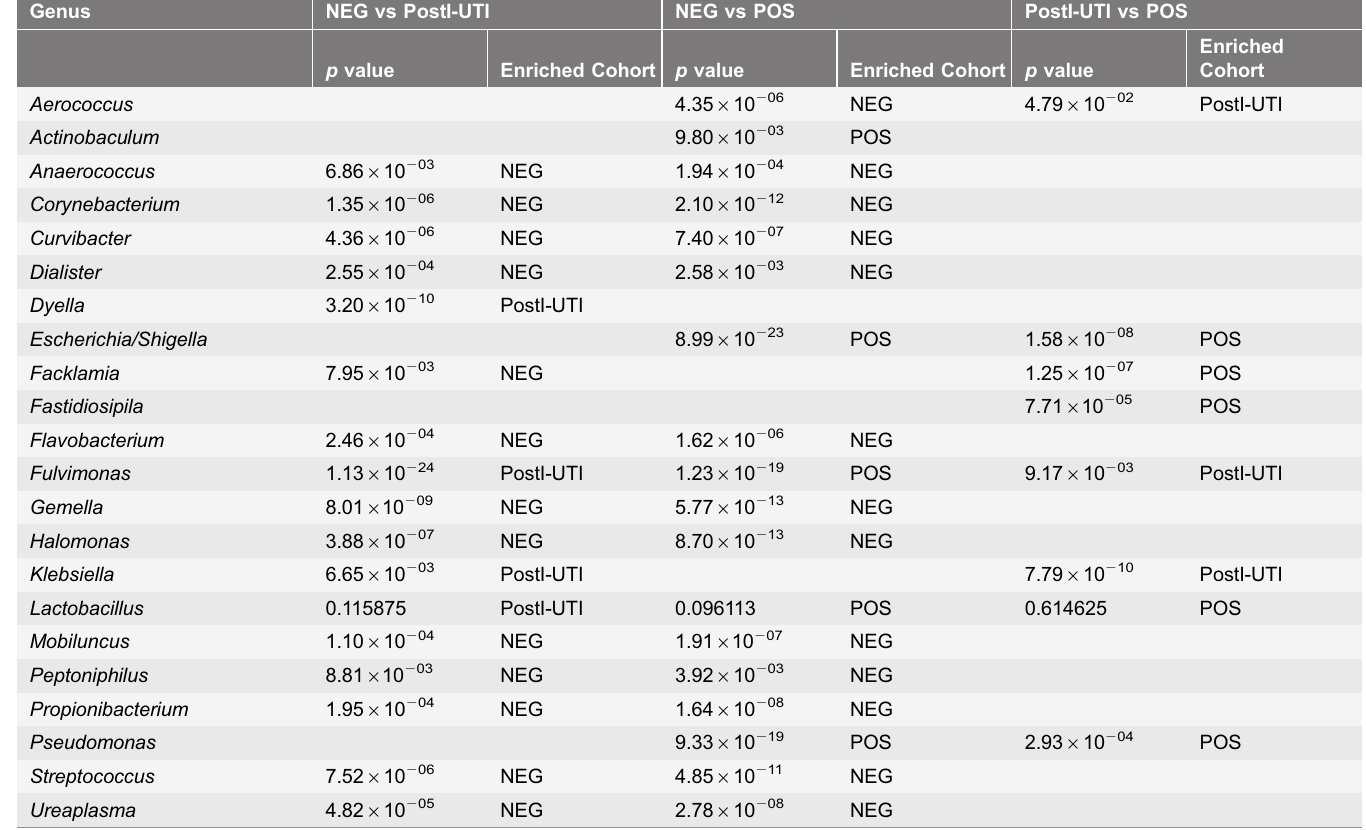
Table 3. Wilcox analysis between Genus and Cohort.